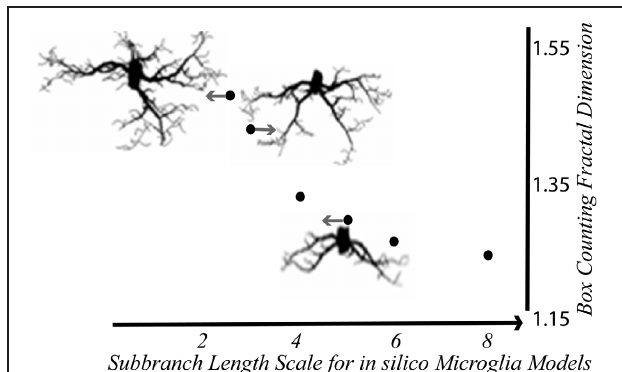
FIGURE 5 | In silico microglia illustrate the relationship between the D B and branching features. The D B decreased with scale—that is, it increased nonlinearly with the relative length of sub-branches Modified from Karperien (2004); models generated with MicroMod (Karperien, 2001c; Jelinek et al.,